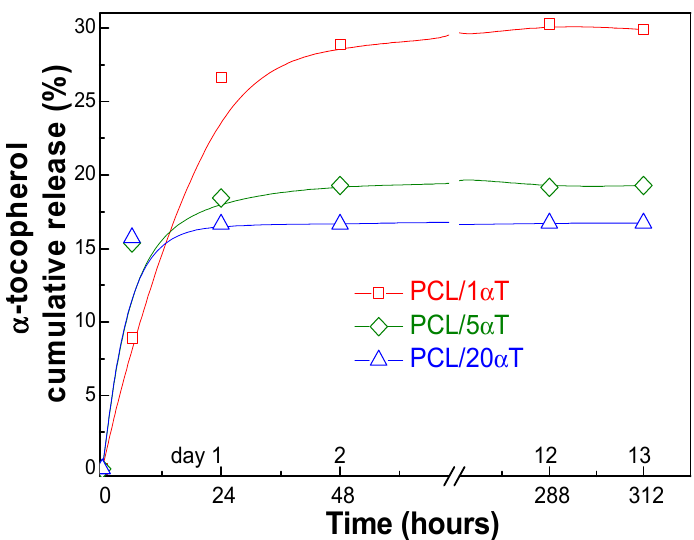
Figure 10. Migration of α -tocopherol from electrospun PCL/ α T fibers into 95% ethanol.